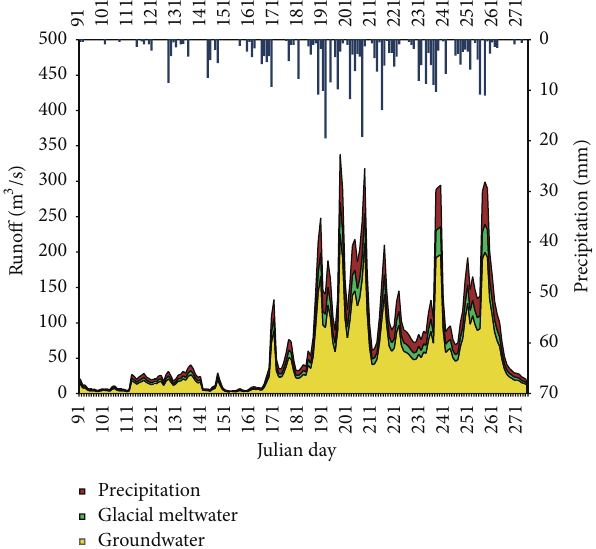
Figure 8: The conclusion of hydrograph